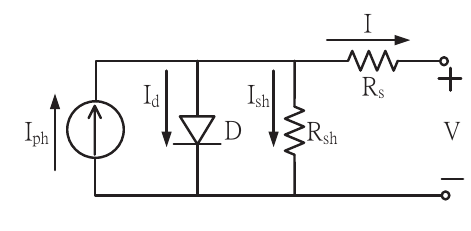
Figure 11. PV-equivalent circuit.